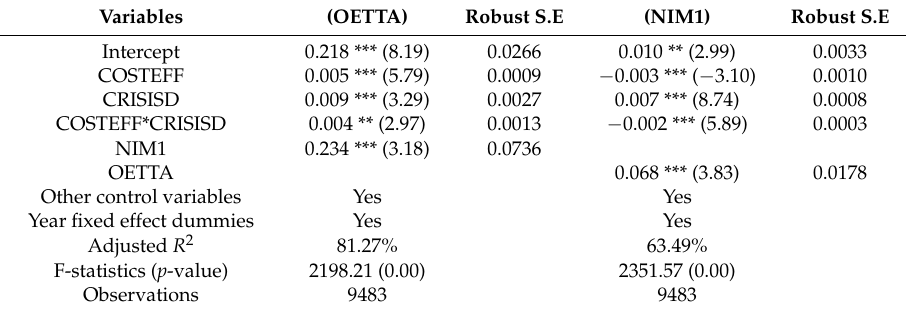
Table 10. Impact of Cost Efficiency on Bank Capital and the Cost of Financial